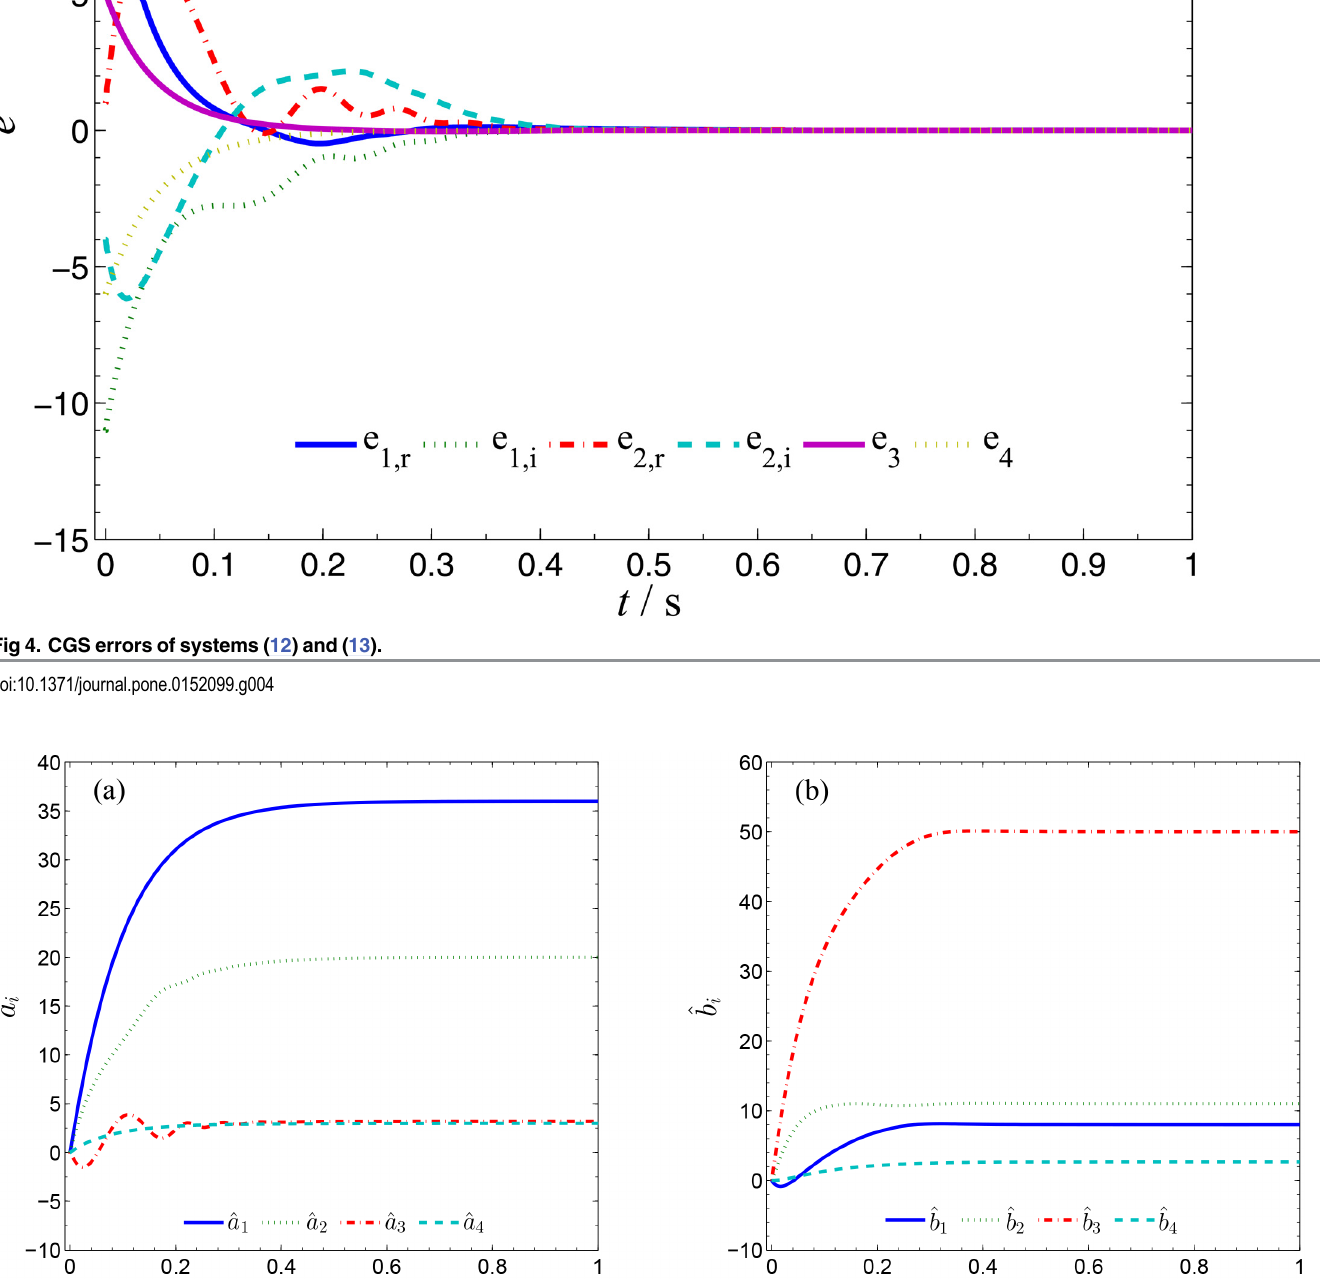
PLOS ONE | DOI:10.1371/journal.pone.0152099 March 24, 2016 10 /